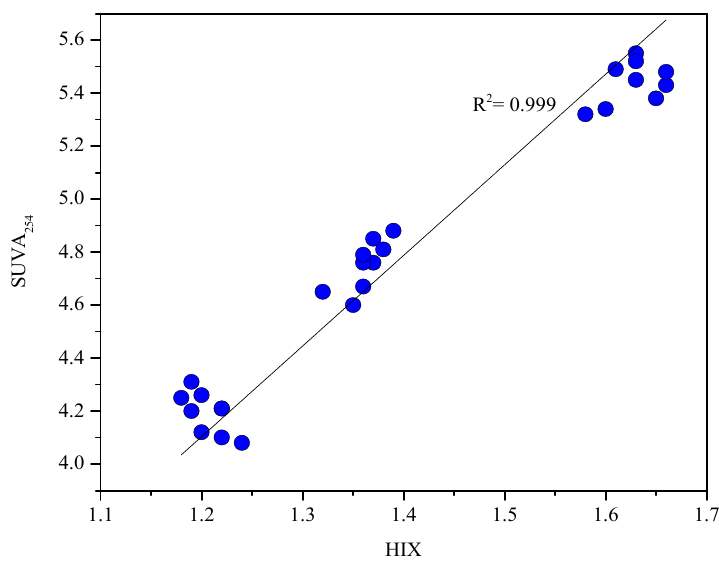
Figure 6. Pearson Correlation of HIX and SUVA 254 , n = 27.